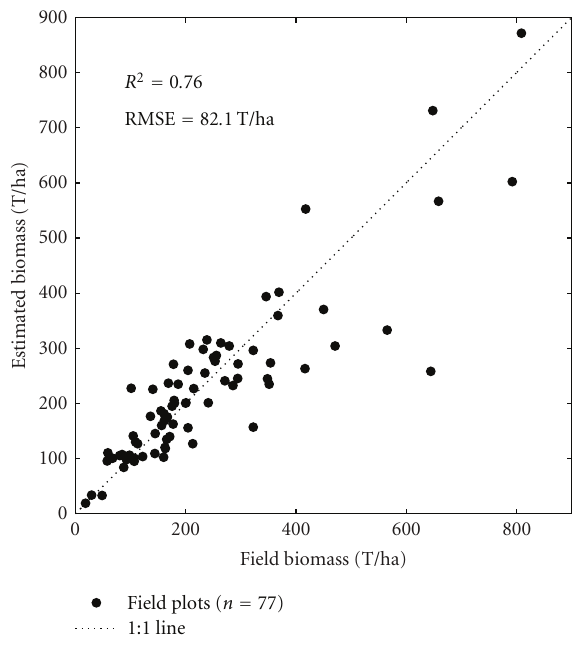
Figure 2: LiDAR-predicted versus field biomass over the 77 field plots in the Sagehen Experimental Forest in Sierra Nevada, California.